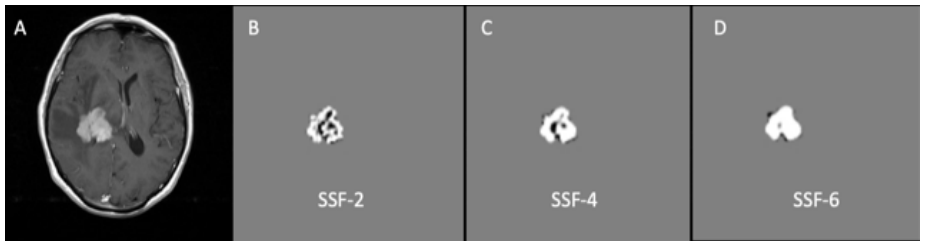
Figure 3. Example of the MRTA filtration process applied to a T 1 CE image ( A ) in a patient with PCNSL using fine ( B ), medium ( C ), and coarse filtration ( D ).